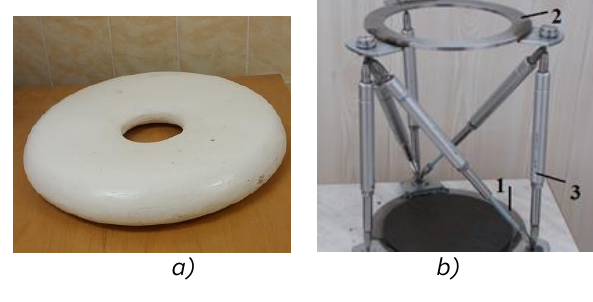
Figure 1. Device model of WPI